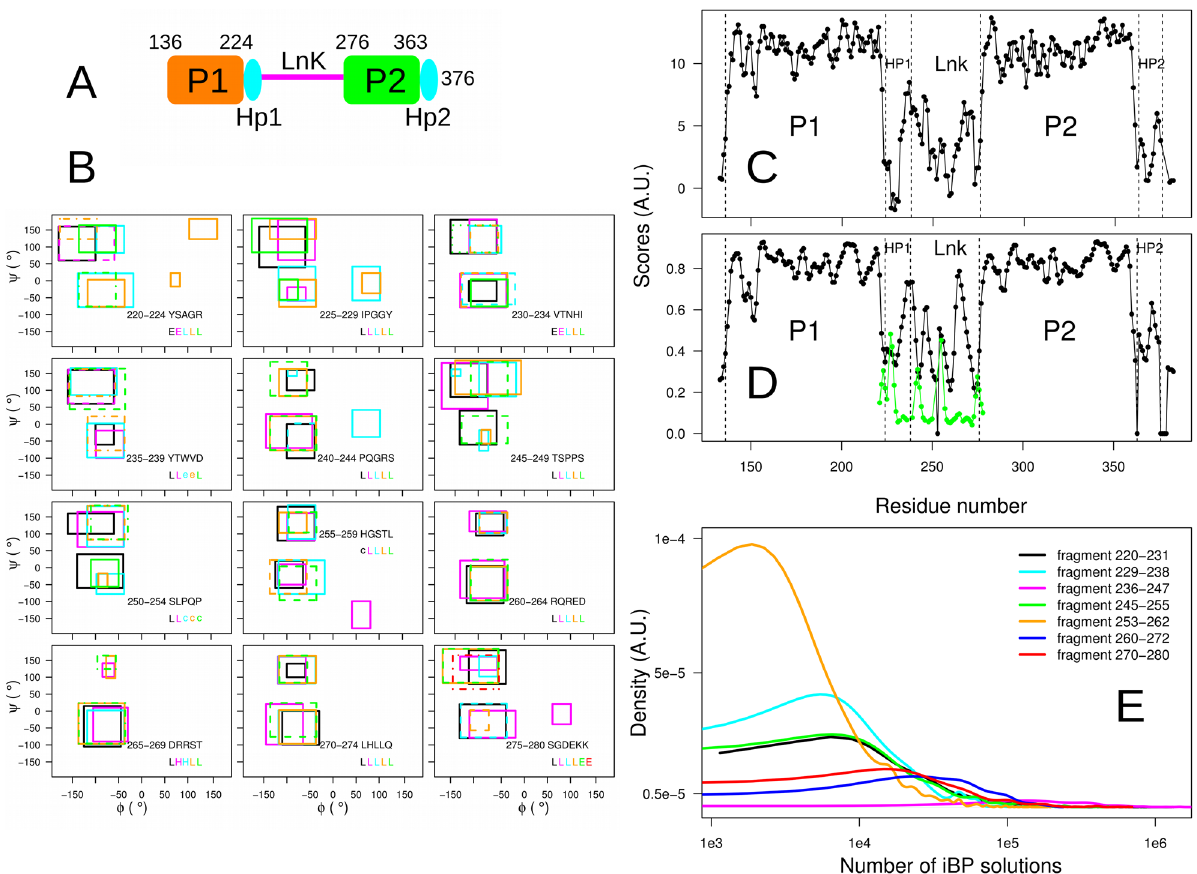
Figure 1. Exploration of the conformational space of Lnk. ( A ) Scheme of the primary structure of the tandem domain protein P1LnkP2 spanning residues 136–376 of protein whirlin. The β hairpins located after the PDZ domains P1 and P2 and corresponding to residues 225–238 and 363–376 are colored in cyan and labeled Hp1 and Hp2. ( B ) Boxes defining the φ and ψ intervals sampled during the iBP calculations. On each panel, for five consecutive residues of the linker (six residues 275–280 on the right bottom panel), the boxes are drawn in different colors for each residue and are plotted with different line types in order to reduce box overlays. The corresponding residue sequences are given on each panel along with the secondary structure prediction (H,E,L,e,c) proposed by TALOS-N 28 , colored in the same way than the boxes. C-D. Disorder prediction along the residues of P1LnkP2 by Chemical shift Z-score for assessing Order/Disorder (CHEZOD) 29 ( C ), by random coil index (RCI) 30 calculated with TALOS-N 28 ( D , black curve) and by 1-coil ( D , green curve) where coil is the percentage of coil predicted by δ 2D 31 . As the δ 2D approach is specially designed for disordered protein regions, it was only applied on the Lnk region. ( E ) Distribution of the number of solutions for individual iBP calculations realized on a given peptide fragment. For the sake of clarity, the two axes are drawn in logarithmic scale. The panel ( A ) was prepared using LibreOffice 6.0.7.3 57 and the other panels using R 3.4.1 58